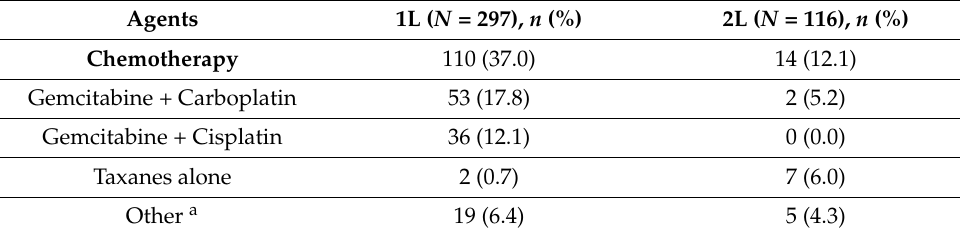
Table A1. Palliative systemic therapy by